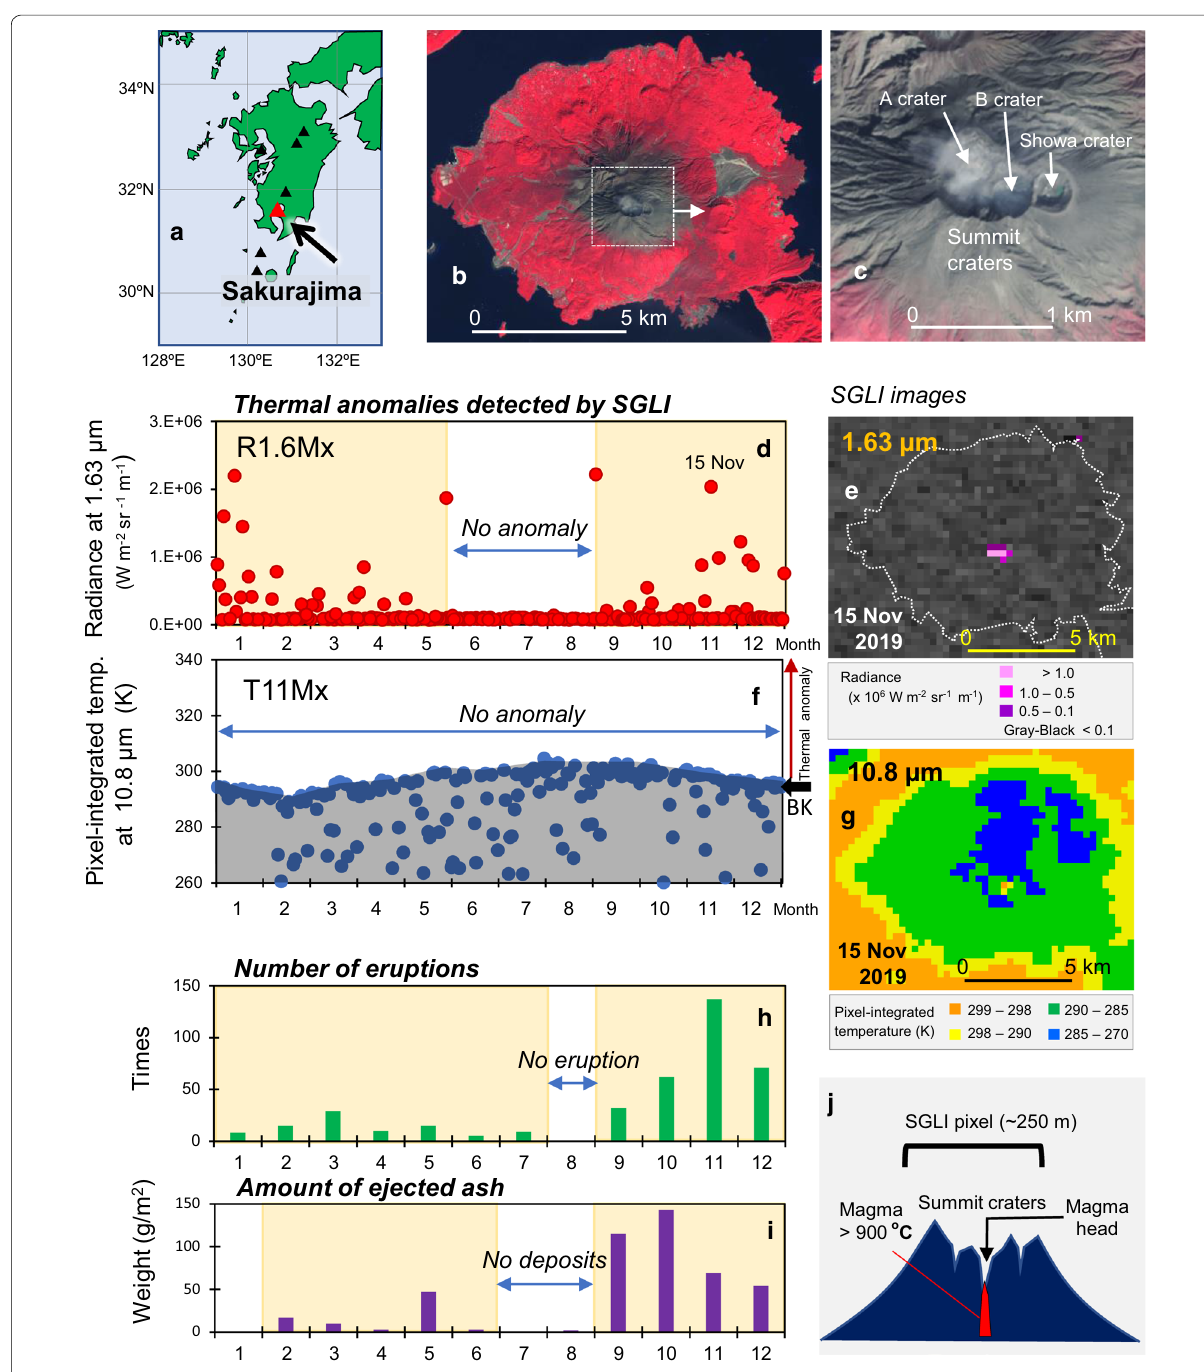
Fig. 6 a Location of Sakurajima volcano. b Topography of Sakurajima volcano (Sentinel-2 image). c Summit craters (Minamidake) of Sakurajima volcano (Sentinel-2 image). d Time-series variation of thermal anomaly (R1.6Mx) detected in the 1.63 µm band with the SGLI between January and December 2019. e SGLI 1.63 µm image of 15 November (radiance). f Time-series variation of thermal anomaly (T11Mx) detected in the 10.8 µm band with the SGLI between January and December 2019 (pixel-integrated temperature). g SGLI 10.8 µm image of 15 November. h The number of explosive eruptions reported by JMA (JMA, 2019). i Amount of ashfall deposits reported by JMA (JMA, 2019). j Possible model to explain the observation results obtained by the SGLI 1.63 and 10.8 µm